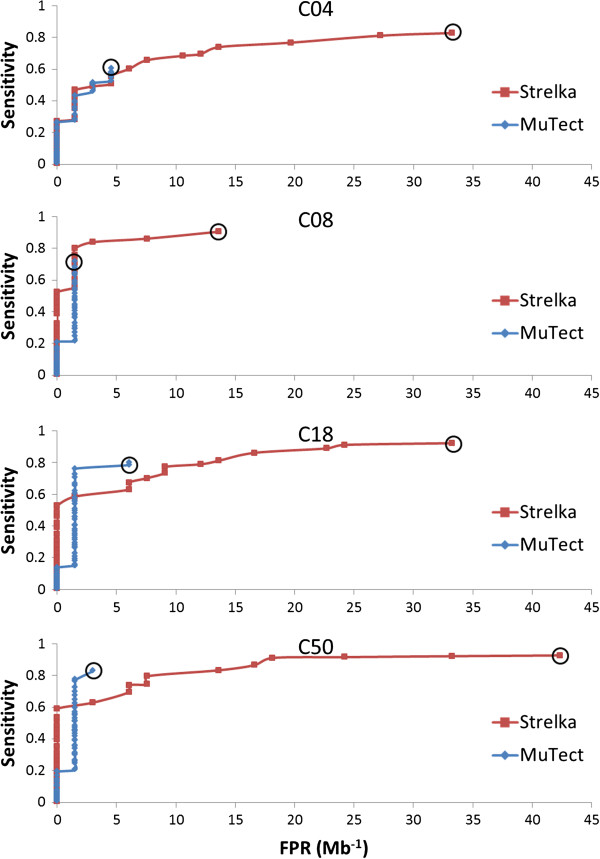
ROC-like curves summarizing sensitivity and specificity of MuTect and Strelka. Sensitivity and FPR (per Mb) plots using various values of MuTect LOD threshold and Strelka QSS_NT threshold generated from one dilution series replicate of amplicon sequencing data. Original thresholds in each final model are marked with black circles (corresponding to outputs in Figure 2).